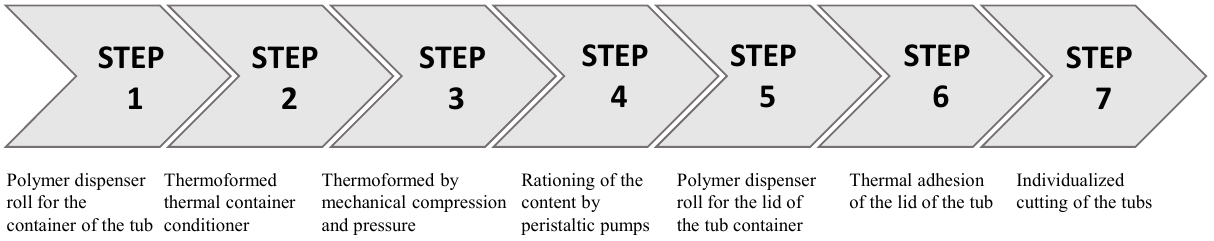
Figure 2. Sub-process in thermoforming and terrine filling machines.